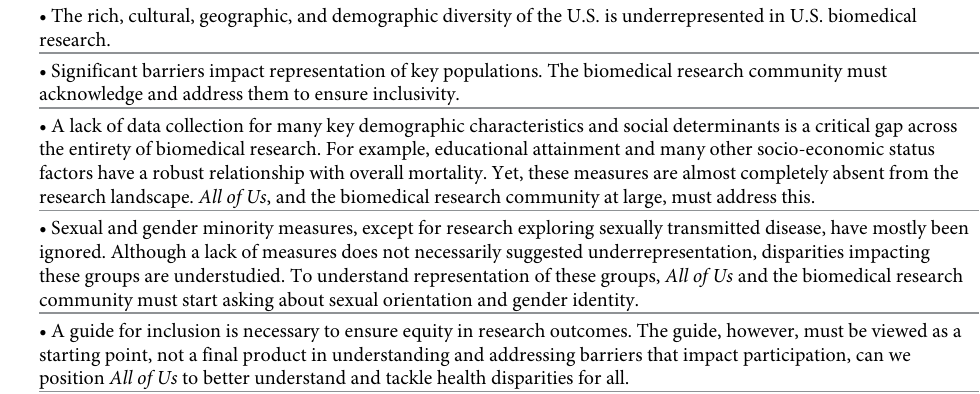
Table 2. Key points learned in developing the All of Us guide for diversity and